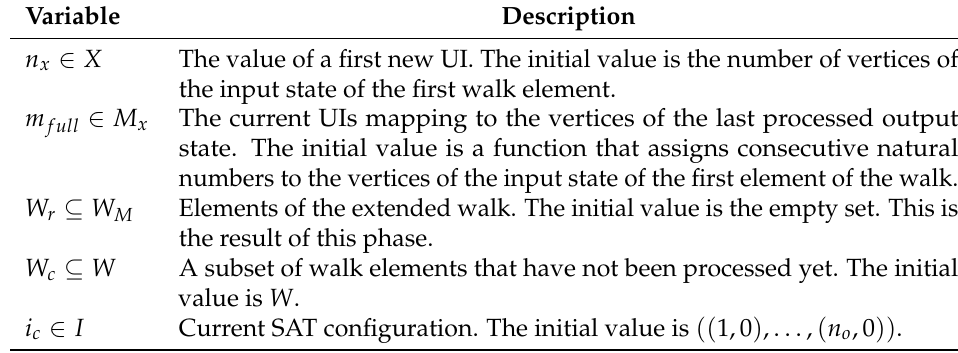
Table 11. Auxiliary variables of the Phase 2